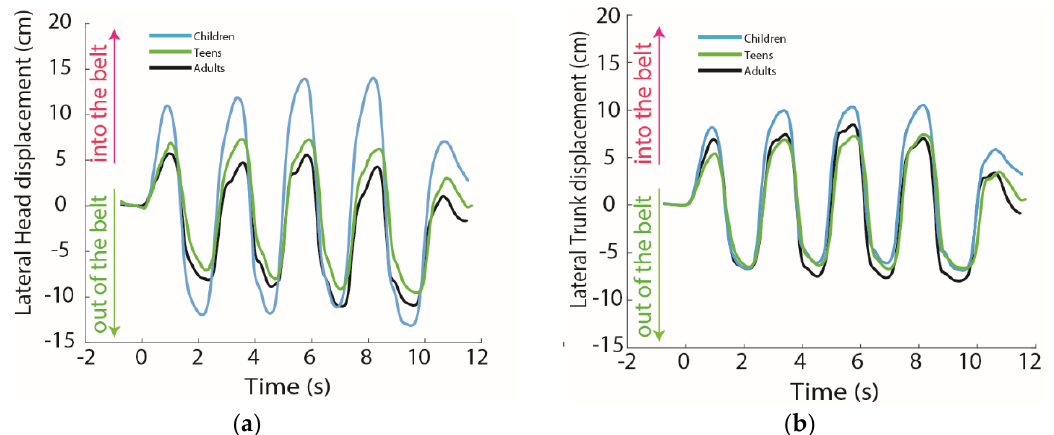
Figure 3. Time series of head and trunk displacement averaged for each age group. Graphs with standard deviations are reported in the Appendix A but not on this graph for visual clarity. ( a ) Lateral head displacement (cm); ( b ) Lateral trunk displacement (cm).